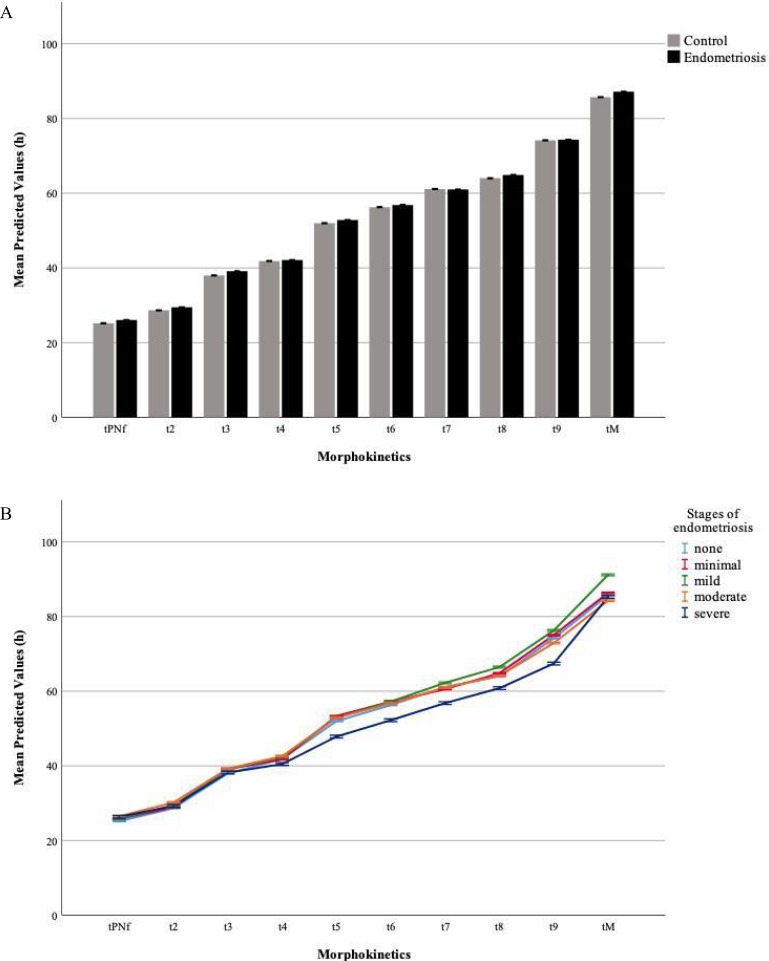
Morphokinetic parameters of early embryo development.A) The mixed-model analysis revealed a significant main effect of time (p<0.001) with post-hoc tests showing that any time needed to reach a specific developmental stage was significantly different from all the others (all p<0.001). Embryos of endometriosis patients showed the same absolute morphokinetic parameters as the control group. B) Subgroup analysis of the different stages of endometriosis and the control group also revealed a significant main effect of time (p<0.001). Looking at the significant overall interaction effect (time*group, p<0.01) more in detail, embryos of severe endometriosis patients reached t9 faster than patients with minimal or moderate endometriosis as well as the control group (all p<0.01). Time gain equalized again at tMor. Data are shown as mean predicted values [95% CI].